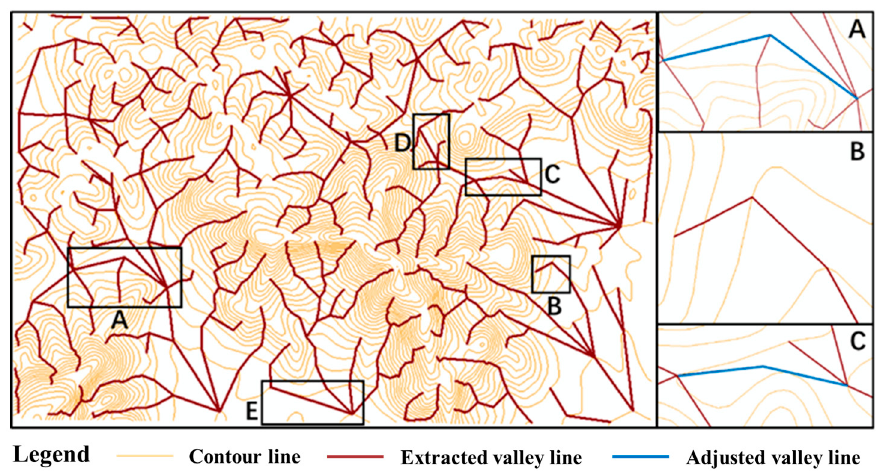
Figure 11. Valley line extraction results from the method proposed in this study.